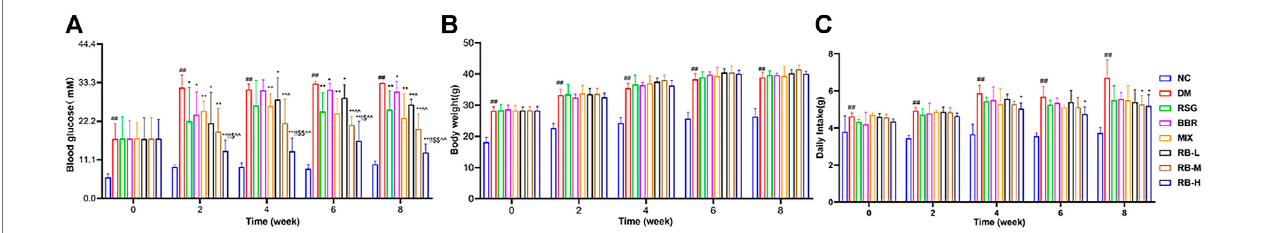
FIGURE1| PhysiologicalcharacteristicsofRB-treateddiabeticKKAymice. (A) Randombloodglucose; (B) Bodyweight; (C) Dailyfoodintake.Dataareexpressed as themean ±SD, n =7 per group. # p < 0.05, ## p < 0.01, vs. NC group; * p < 0.05, ** p < 0.01, vs. DM control group; $ p < 0.05, $$ p < 0.01, vs. RSGgroup; ^ p < 0.05, ^^ p